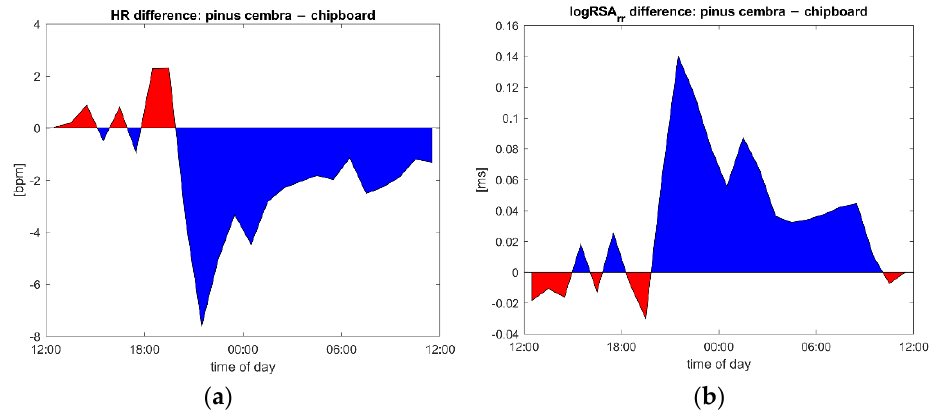
Figure 8. ( a ) Time course of heart rate differences between sleeping in the stone pine ( Pinus cembra ) bed and sleep and the control condition (chipboard bed). Blue indicates lower heart rate in the stone pine bed and red, the lower heart rate in control condition. ( b ) Differences in the vagal tone (logRSA). Here, blue indicates a higher vagal tone in the stone pine bed and red, under the control condition.